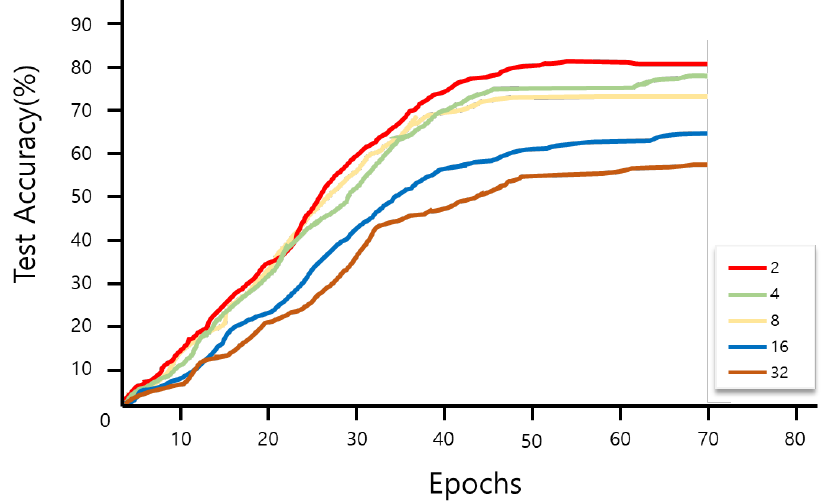
Figure 20. Learning results with different batch sizes.